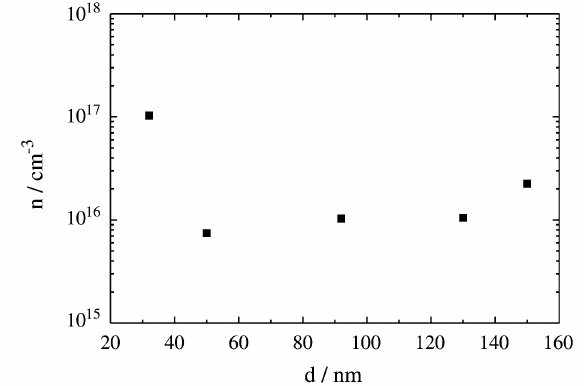
Figure 6. Charge carrier density in Ni/OPPVDBC/Al devices as a func- tion of device